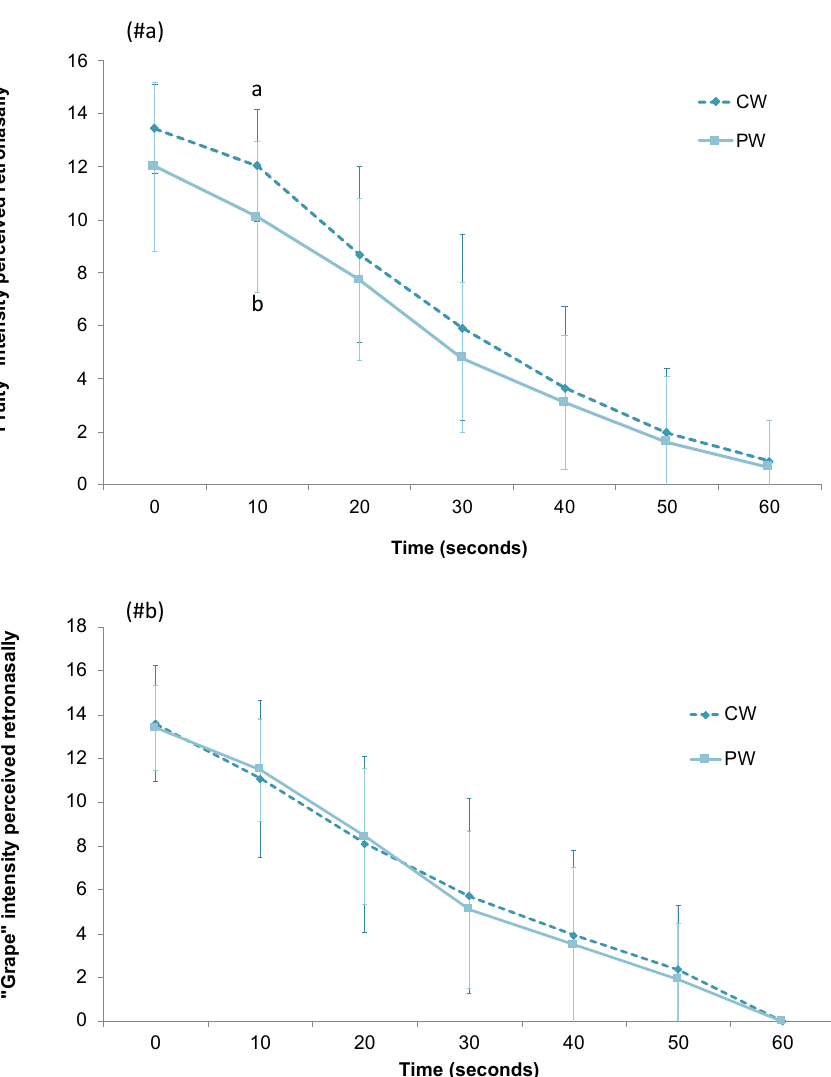
Figure 4. Intensity scores of the fruity ( #a ) and grape ( #b ) descriptors determined retronasally by the trained panel ( n = 10) in the control wine (CW) and in the wine supplemented with the GSE (PW). Different letters across the different time points indicate significant differences between wines ( p < 0.05, α < 0.05).